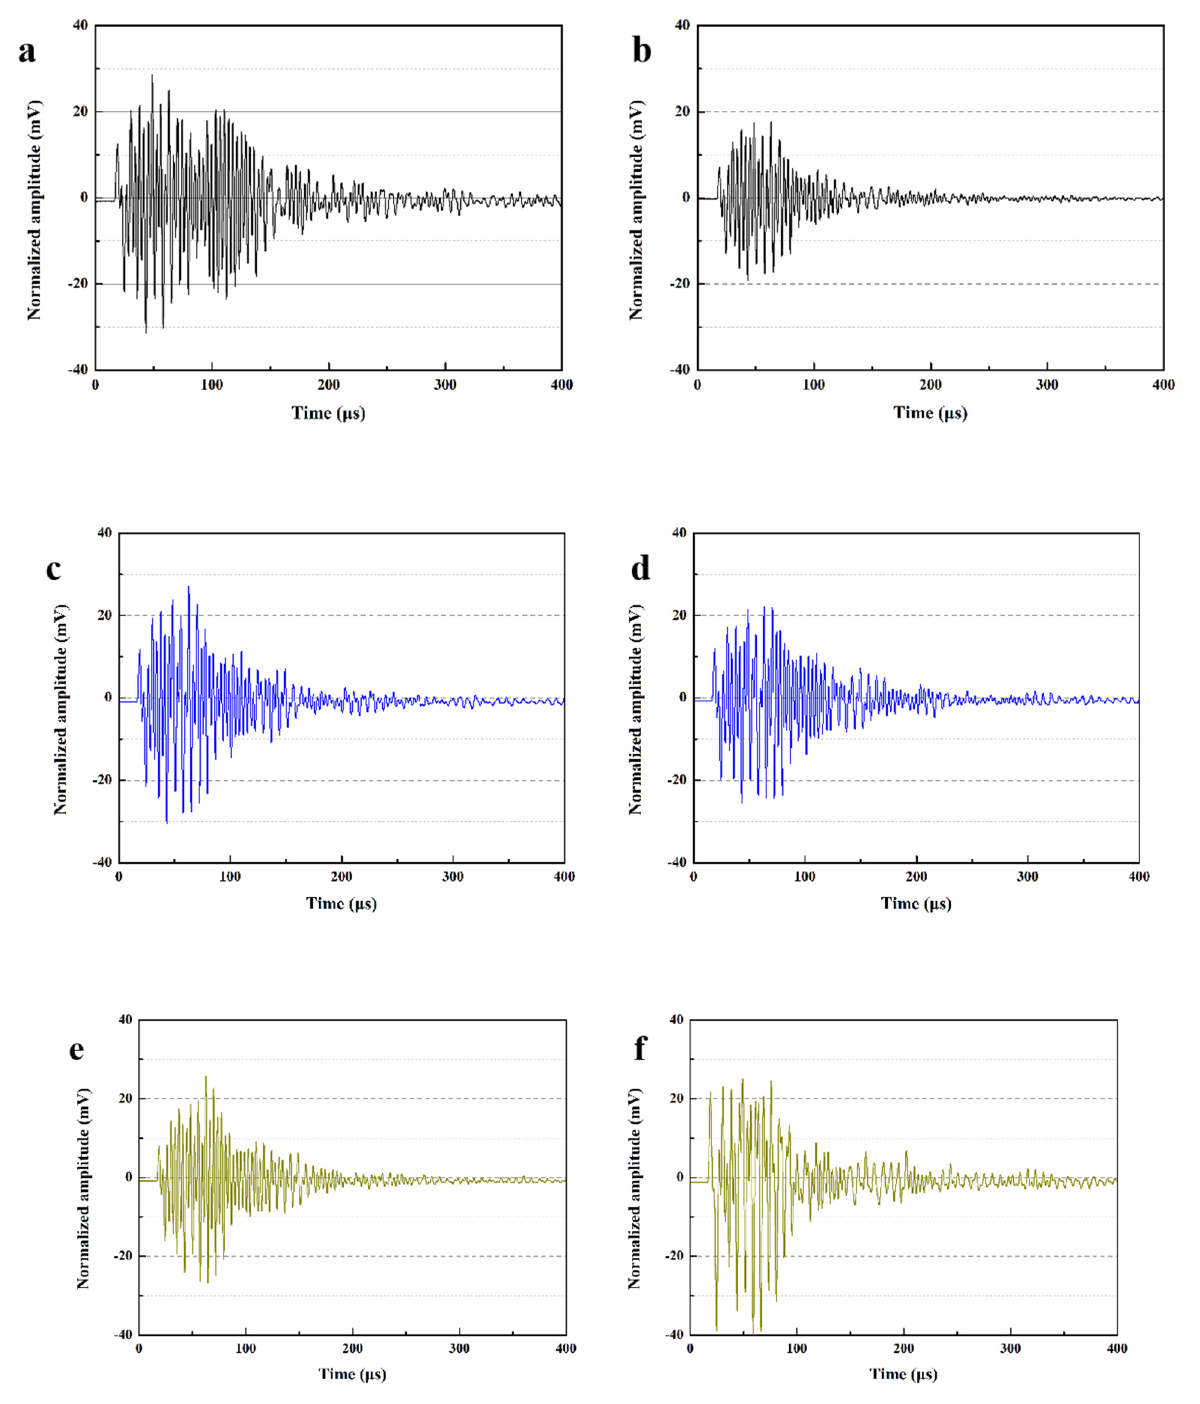
Figure 12. Ultrasonic waveform of mortars. ( a ) initial ultrasonic waveform of SJ-0, ( b ) ultrasonic waveform of self-repaired SJ-0, ( c ) initial ultrasonic waveform of SJ-1, ( d ) ultrasonic waveform of self-repaired SJ-1, ( e ) initial ultrasonic waveform of SJ-2, ( f ) ultrasonic waveform of self-repaired SJ-2.